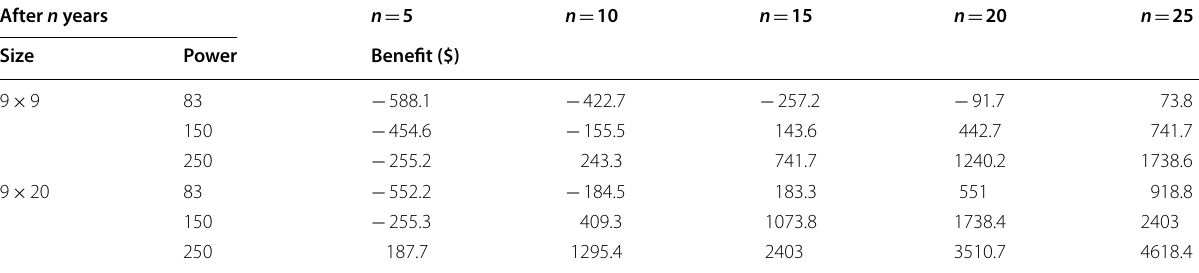
Table 7 The economic estimates of the proposed reconfiguration method for TCT-based PV array After n years